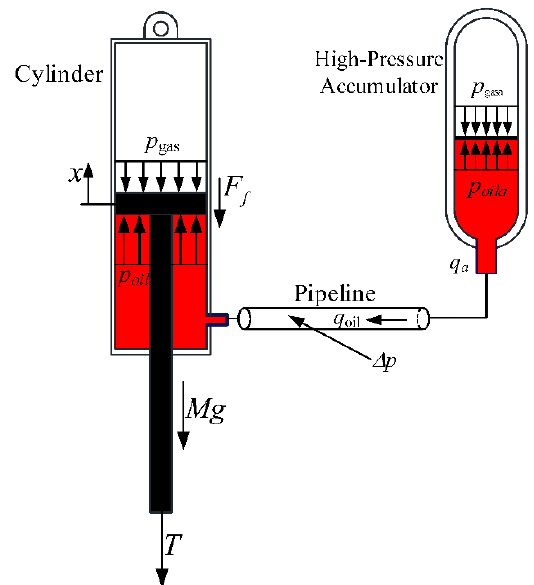
Figure 4. Model of pipeline.